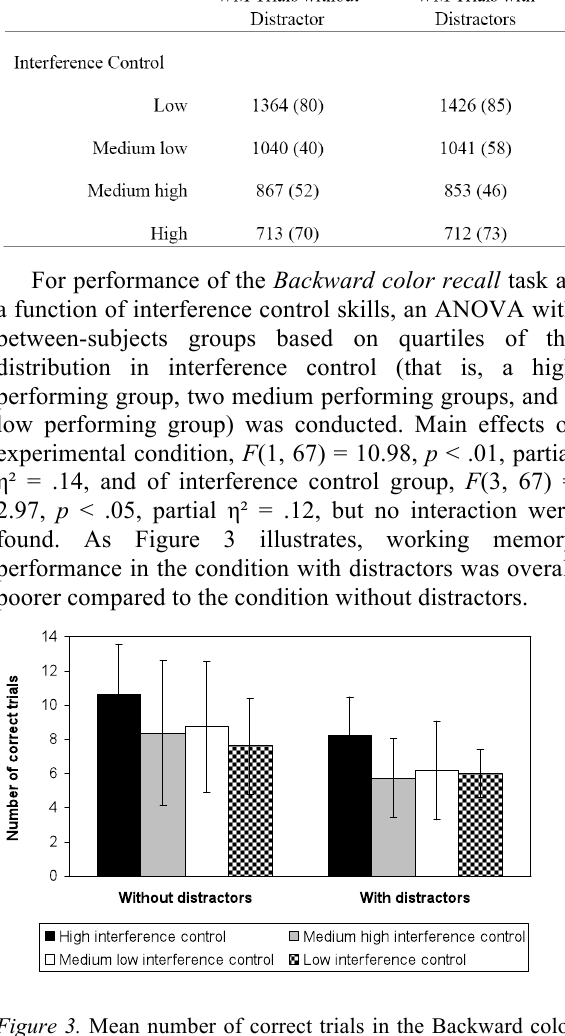
Figure 3. Mean number of correct trials in the Backward color recall task as a function of interference control group (quartiles) and experimental condition. Error bars depict standard deviations.